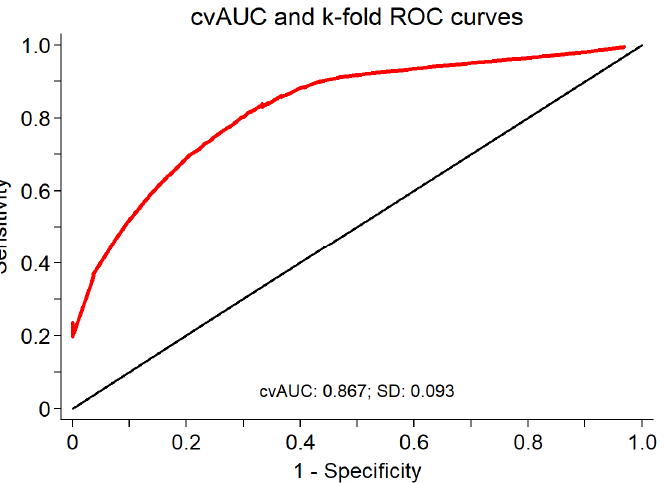
Figure 3. Cross-validated mean area under ROC for LSM, HbA1c, and ALP as a diagnostic test for significant fibrosis ( n = 167).